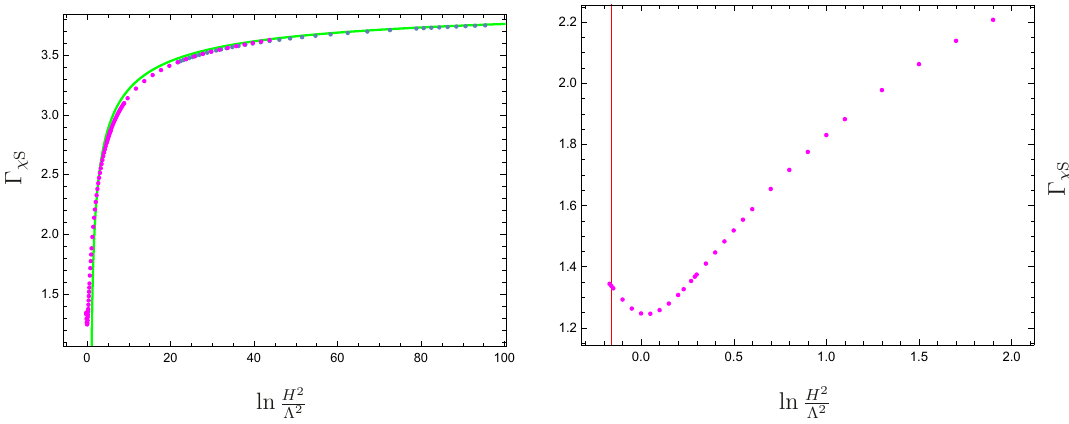
Figure 11 . The lower sub-branch of the n = 4 branch of chirally symmetric fluctuations about TypeA DFP of the cascading gauge theory remains perturbatively stable for H > H s represented by the red vertical